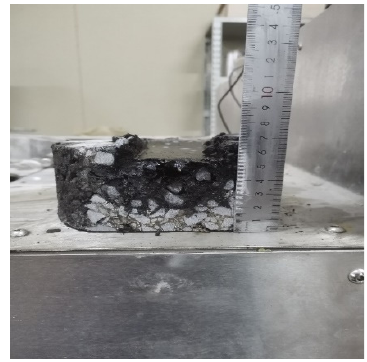
Figure 14. Specimen of HMPR-BF.